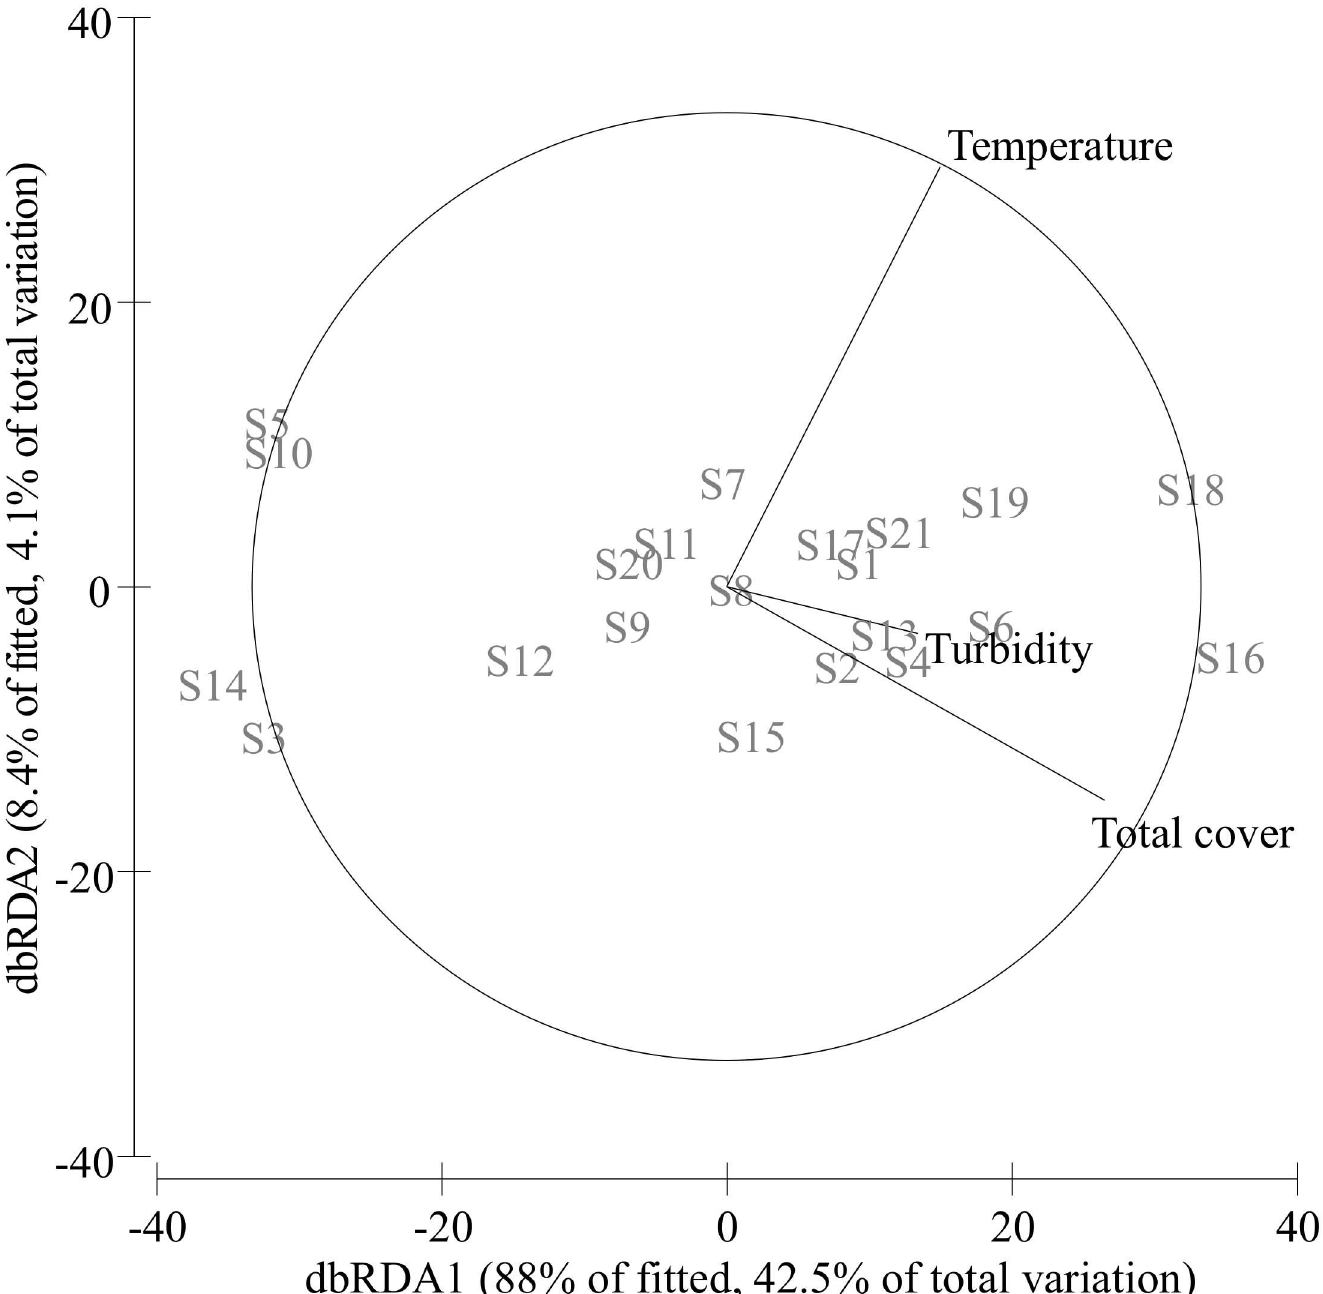
Fig 3. Distance-based redundancy analysis ordination. dbRDA visualizes the positionof the 21 beach sites fitted to the main environmental variables (temperature, turbidity and total vegetationand algal cover) affecting the entire invertebrate community (see Table 3 for statistical results).